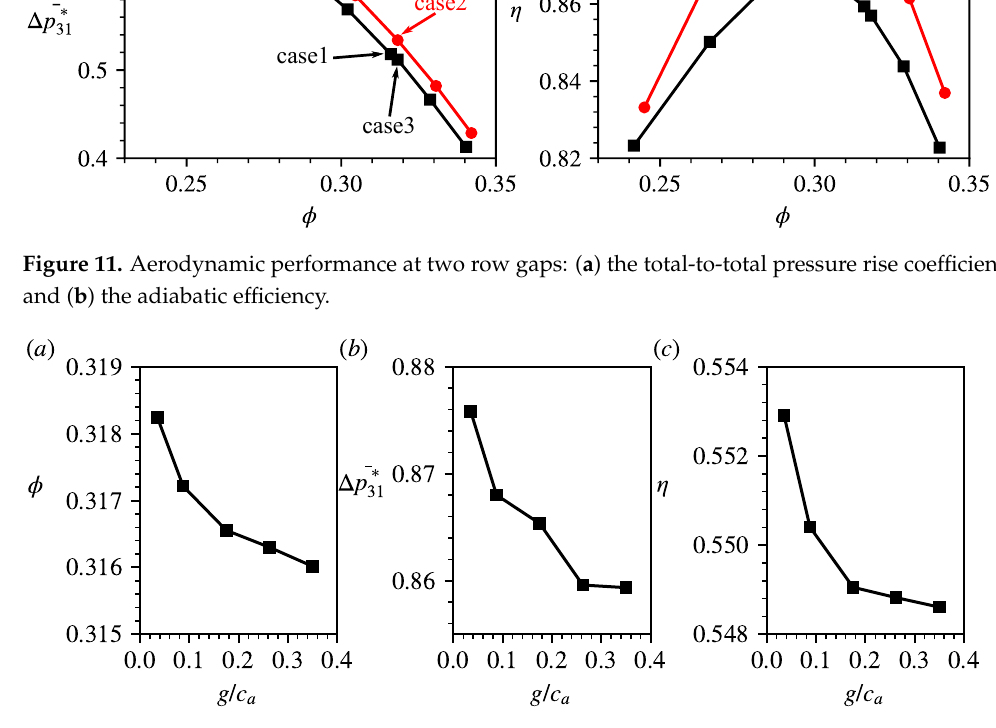
Figure 12. Aerodynamic performance at different row gaps with a fixed back pressure: ( a ) mass flow rate, ( b ) total pressure rise coefficient and ( c ) adiabatic